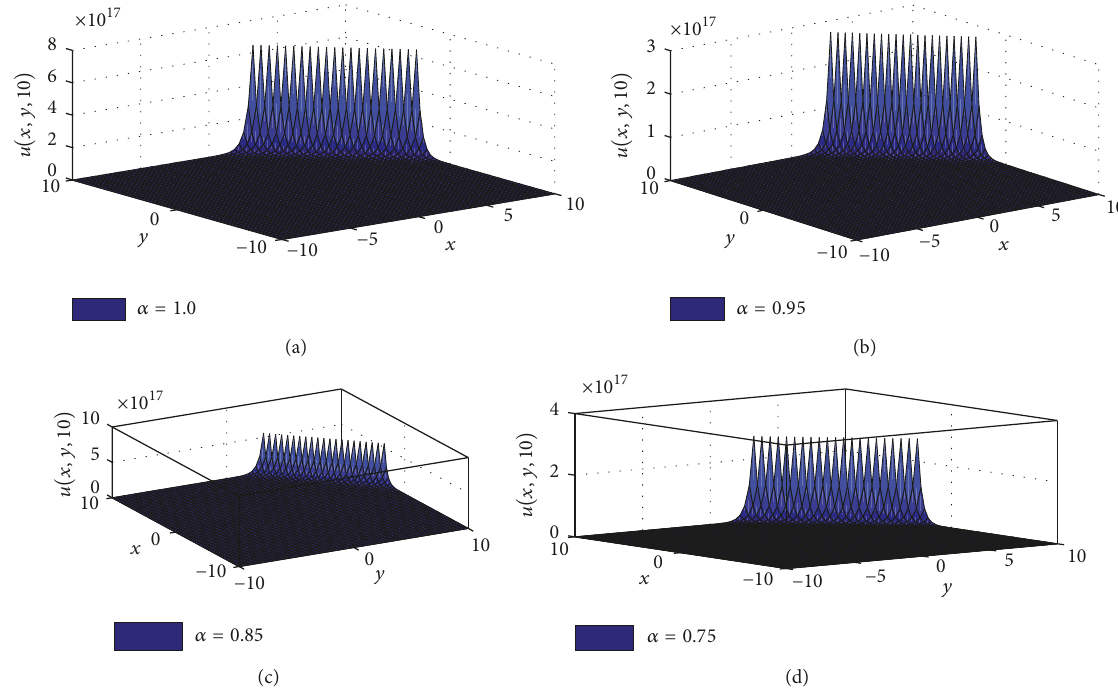
Figure 1: Numerical plots of approximate solutions of Example 6 at various fractional orders and using 𝑟 = 50, 𝑡 = 10.